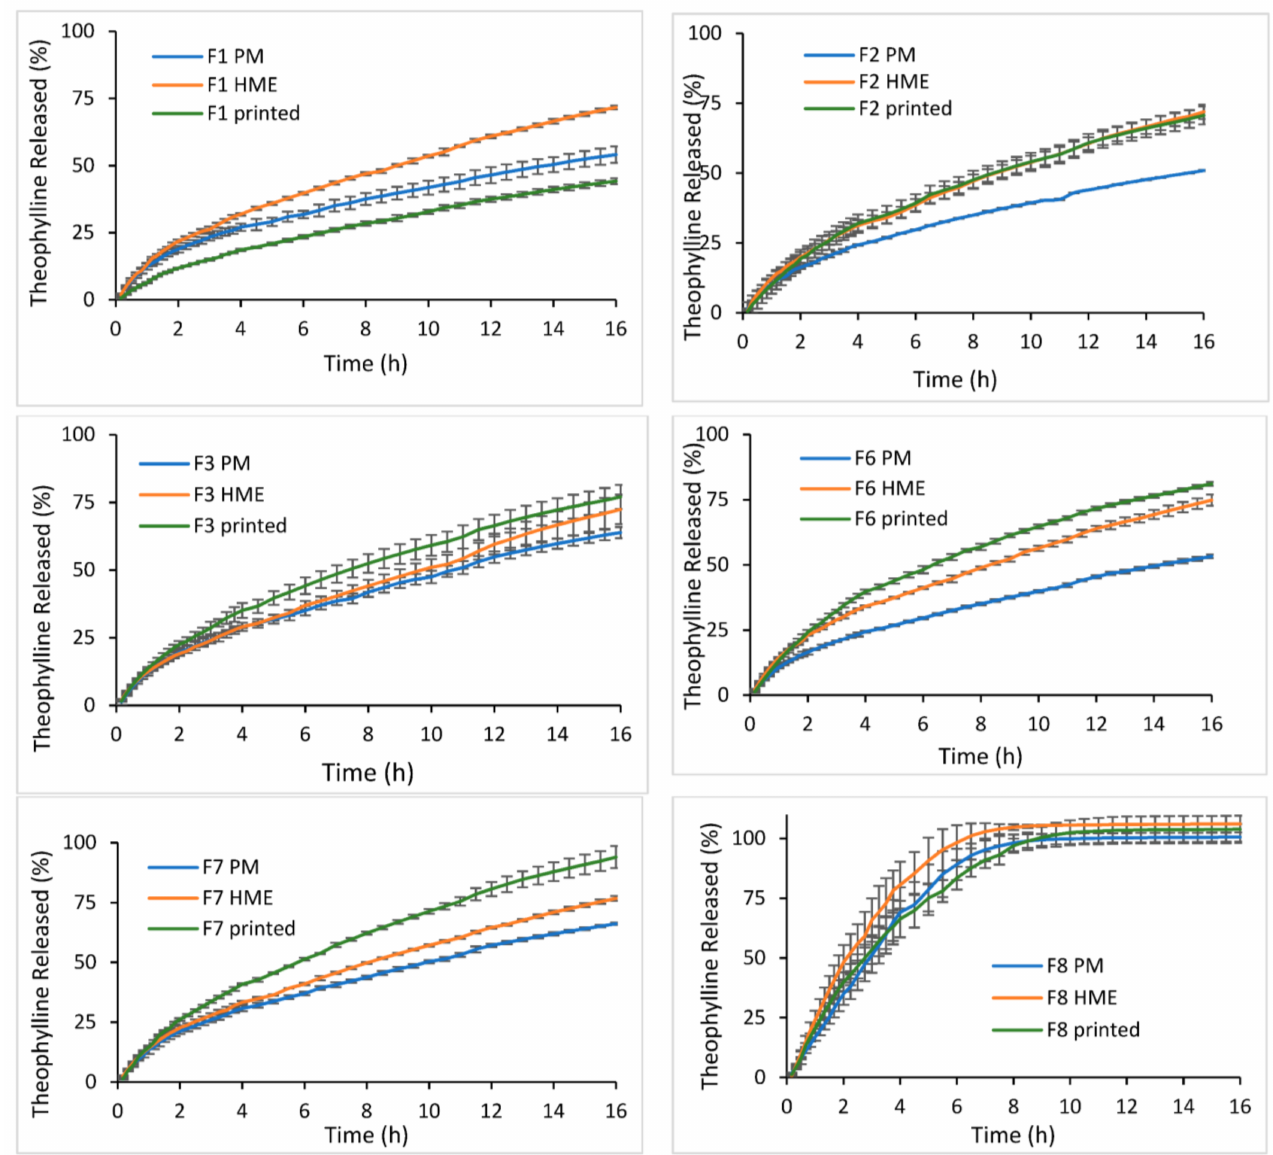
Figure 5. Effect of preparation method on the dissolution profile of theophylline tablets made via physical mixture, HME, and 3D